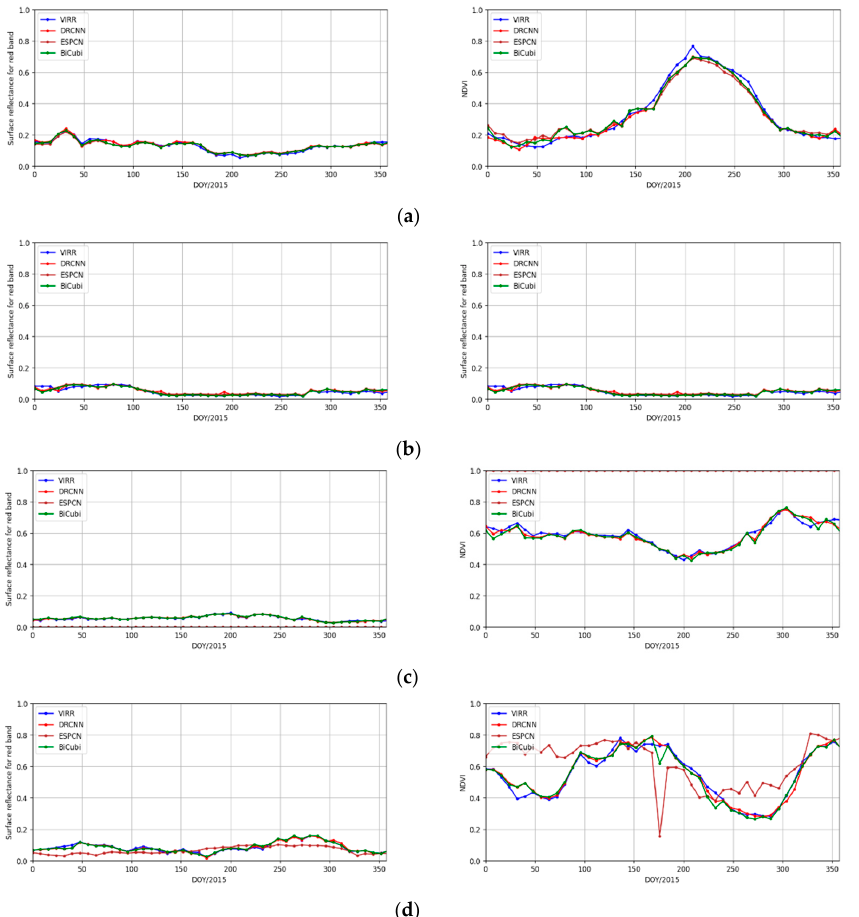
Figure 9. Time series of the downscaled surface reflectance from the DRCNN, the bicubic interpolation method and the ESPCN method, the surface reflectance in the red band from the preprocessed MOD09Q1 product in 2015, and the corresponding time series of NDVI at ( a ) the Zhangbei site, ( b ) the Collelongo site, ( c ) the Barrax site and ( d ) the Maragua site. The left panel is the time series of surface reflectance in the red band and the right panel is the corresponding time series of NDVI. In experiment 2, the surface reflectance in the blue, green, SWIR1 and SWIR2 bands from the MOD09A1 product were downscaled to derive surface reflectance in the corre- sponding bands at 250 m resolution using the DRCNN. Figure 10 shows the downscaled surface reflectance in the blue, green, SWIR1 and SWIR2 bands from the DRCNN on day 265 in 2015 at tiles h26v04 and h19v04. Since there is no 250 m surface reflectance in the corresponding bands, the downscaled surface reflectance in the blue, green, SWIR1 and SWIR2 bands from the DRCNN were compared with the surface reflectance in the corre- sponding bands from the MOD09A1 product, the preprocessed MOD09A1 product and the surface reflectance in the corresponding bands downscaled by the bicubic interpola- tion method and the ESPCN method. The results also demonstrate that the downscaled surface reflectance in the blue, green, SWIR1 and SWIR2 bands from the DRCNN show good consistency with the surface reflectance in the corresponding bands from the MOD09A1 product and the preprocessed MOD09A1 product. Moreover, the downscaled surface reflectance in the blue, green, SWIR1 and SWIR2 bands from the DRCNN were all cloud-free.